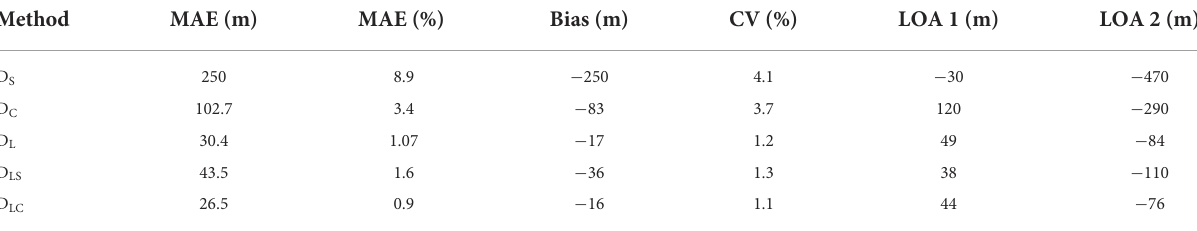
TABLE 2 Error rates for the five distance estimation methods.